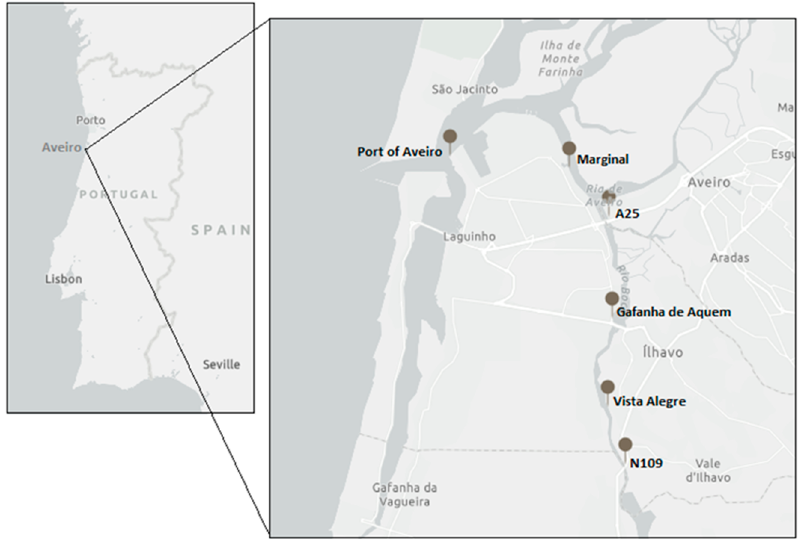
Figure 1. Sampling locations for Fucus vesiculosus , from the inlet of Ria de Aveiro and along the Ílhavo Channel, Portugal: Port of Aveiro, Marginal, A25, Gafanha de Aquém, Vista Alegre, and N109. Map generated with ArcGIS Online ® .